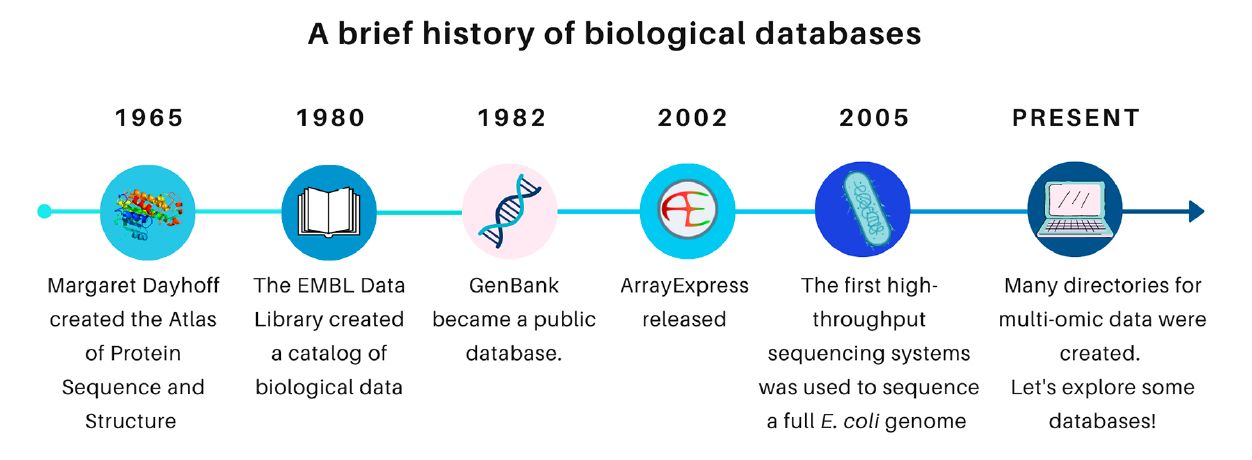
Figure 1 – A brief history of the biological